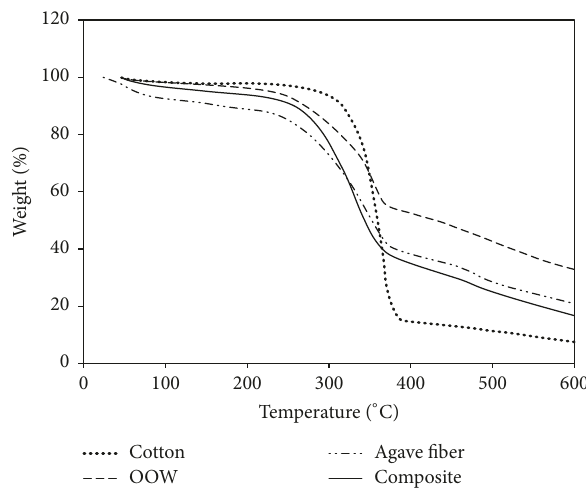
Figure 9: Thermogravimetric analysis (TGA) curves of ingredients and